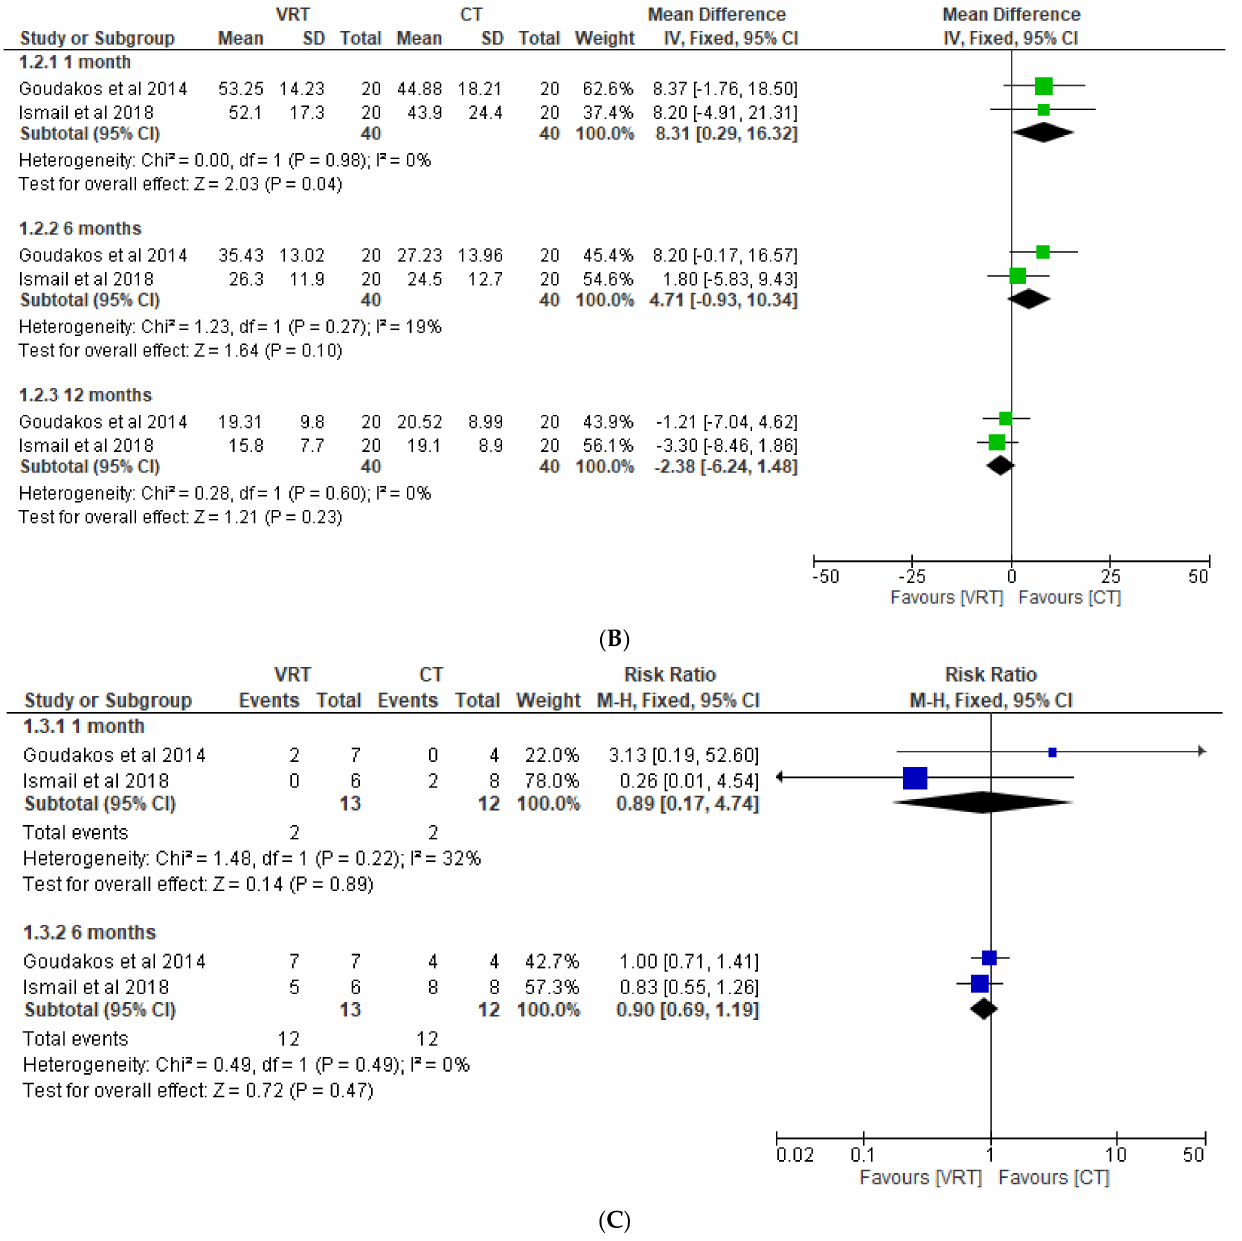
Figure 3. Forest plots of DHI ( A ) and canal paresis ( B ) comparison between VRT and CT groups at 1 month, 6 months, and 12 months; otolith dysfunction recovery risk ratio ( C ) between VRT and CT groups at 1 month and 6 months